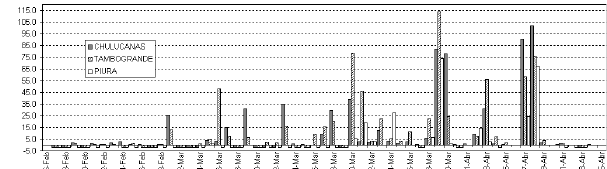
Fig. 5. Daily rainfall (mm) measured at Piura, Chulucanas and Tam- bogrande in 2002. Measurements are made at 07:00 a.m. and nega- tive values indicate missing